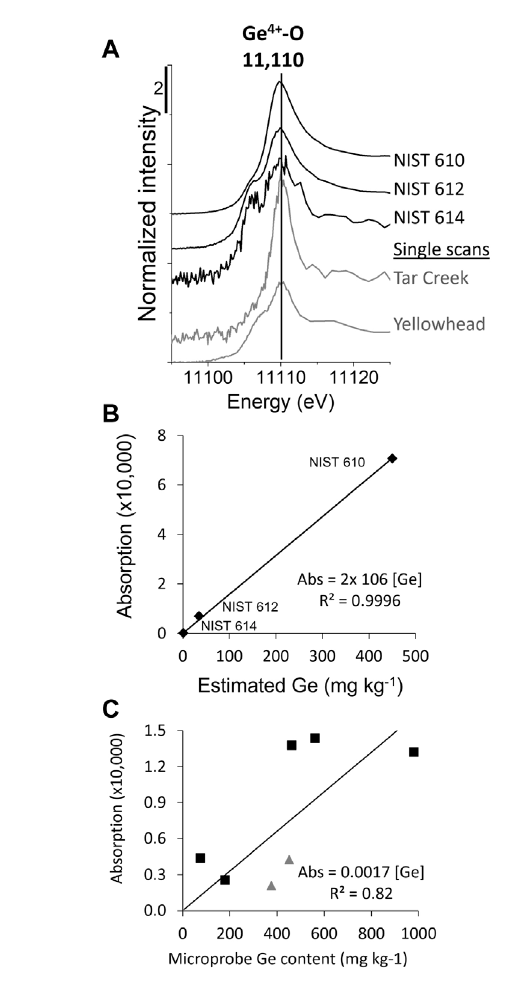
FIGURE 8 Quanti fi cation of Ge in quartz and sphalerite. (A) Quartz XANES spectra, including NIST 610, 612, and 614, containing 447, 36.1, and 0.942 mg kg − 1 Ge, respectively (Jochum et al., 2011). Representative individual quartz μ -XANES spectra from Tar Creek and Yellowhead (gray lines), which were included to give a sense of the noise associated with a single spectrum; (B) Quartz calibration curve; (C) Sphalerite calibration curve (black squares are for Ge 4+ spectra and gray triangles are for Ge 2+ spectra, mixed Ge oxidation state spectra were not included).